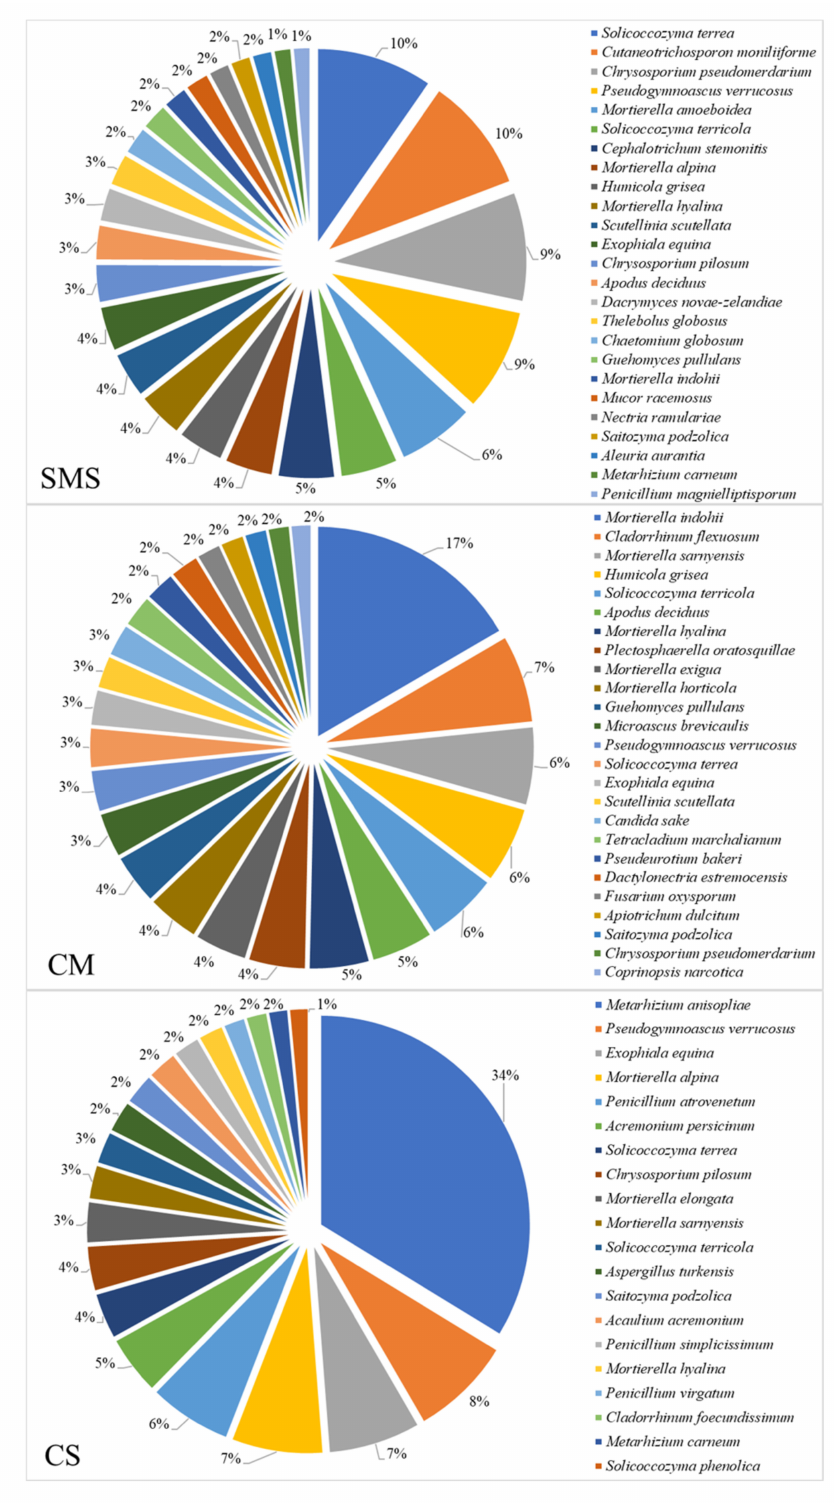
Figure 7. The relative abundance of soil fungal species, which constitute at least 1% among iden- tified species, after the long-term organic treatment presented as core mycobiome. The percent of sequences classified to a fungal species for each treatment was as follows: 37.71% (SMS), 34.69% (CM), 54.69% (CS). SMS—spent mushroom substrate, CM—chicken manure, CS—control soil. Fungal communities were examined through next generation sequencing (NGS) of the ITS1 region using Illumina MiSeq